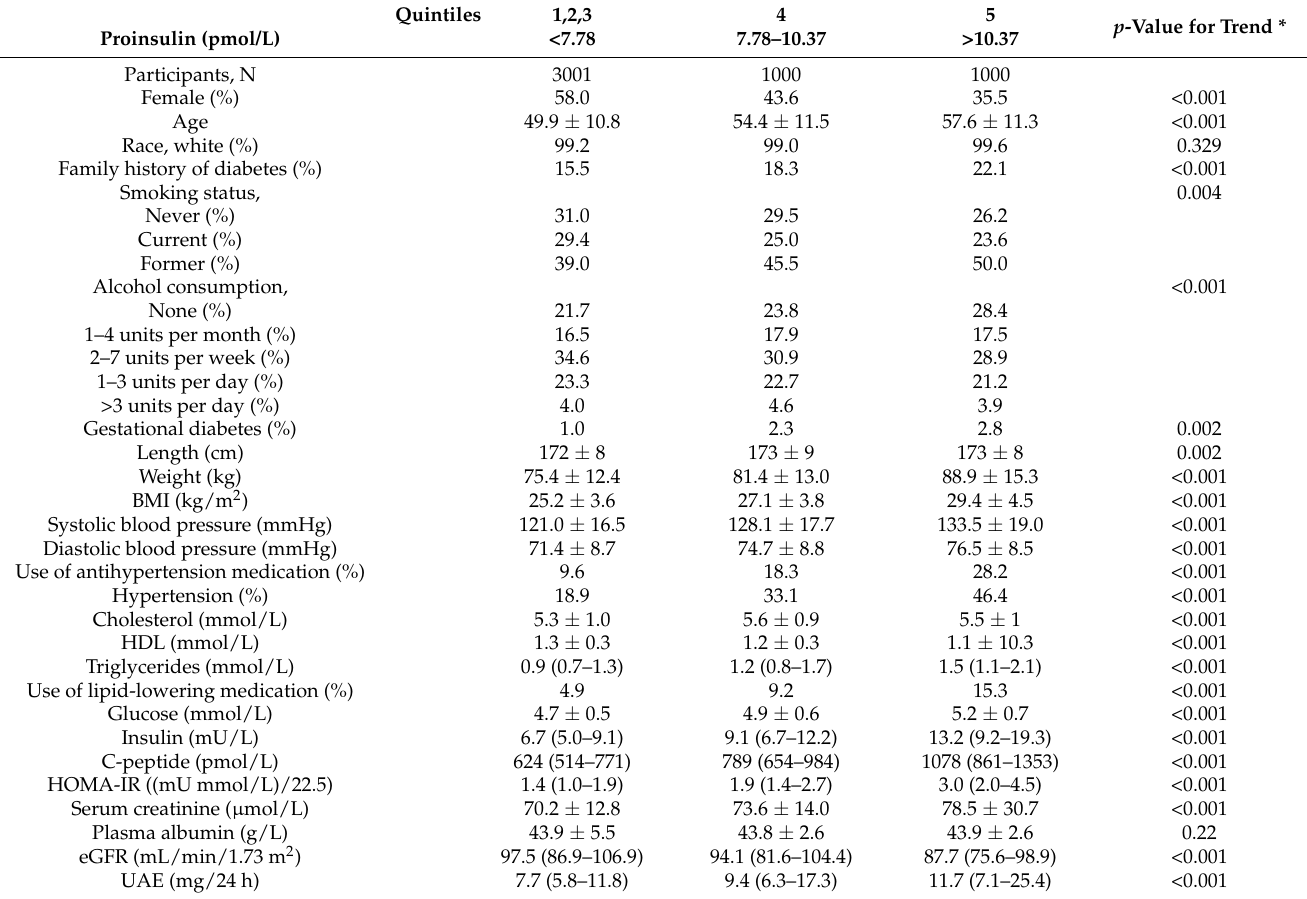
Table 1. Baseline characteristics according to quintiles of proinsulin in 5001 participants of the PREVEND